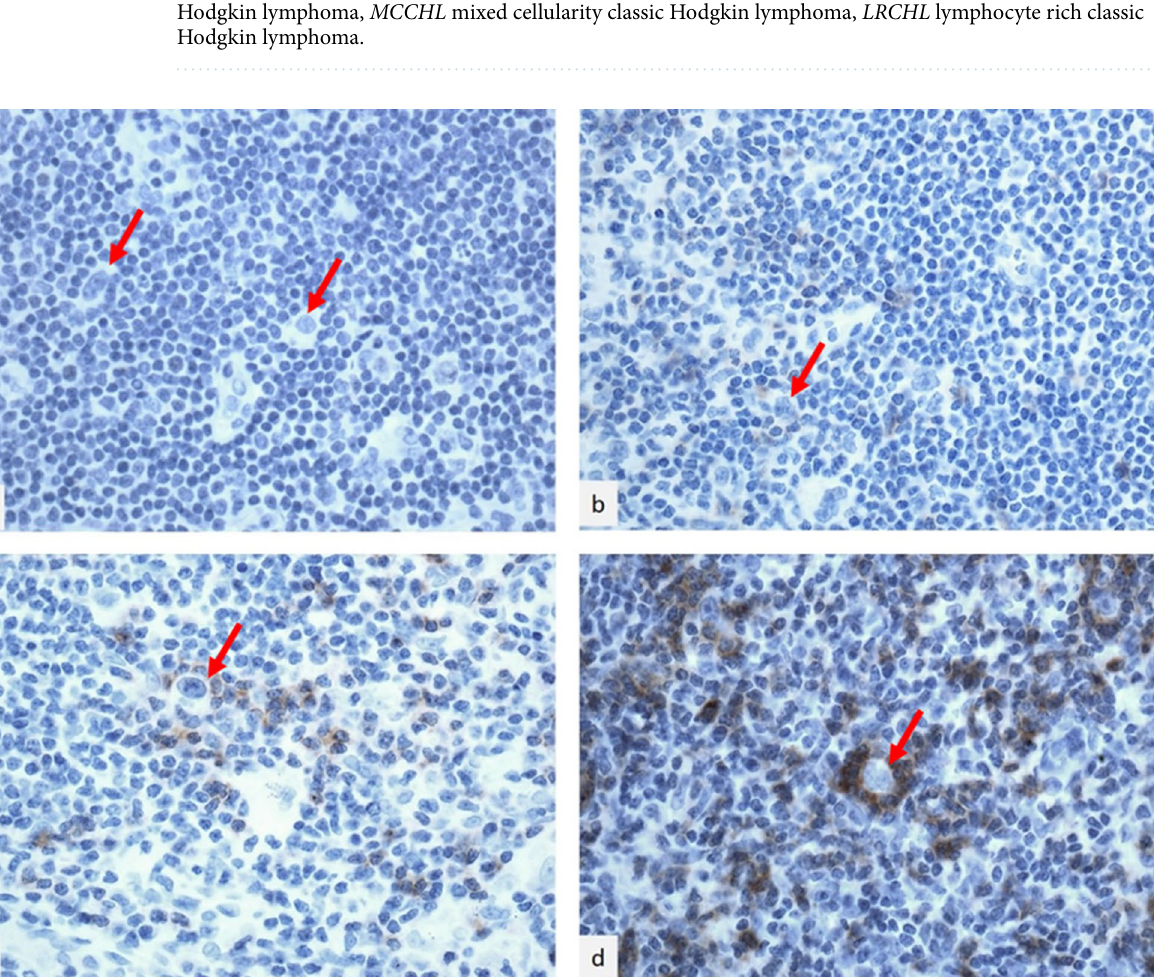
Table 1. Clinical and biological characteristics at diagnosis of patients’ cohort. M male, F female, CR complete remission, PR partial remission, PD progressive disease. Histological subtype: NSCHL nodular sclerosis classic